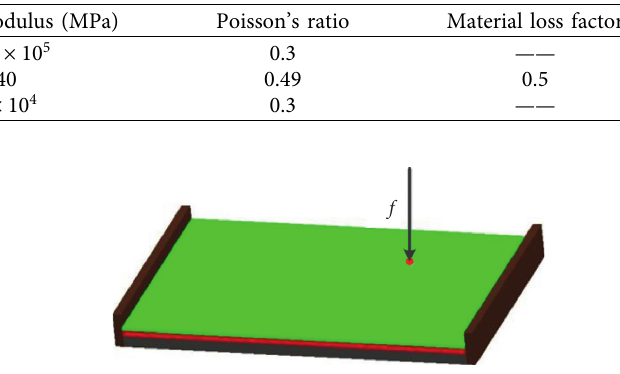
Figure 3: The plate clamped with two short